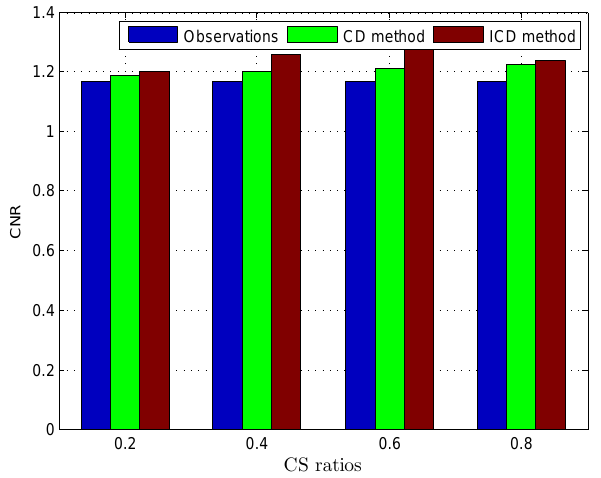
Figure 8. Deconvolution quality assessment for Skin melanoma .